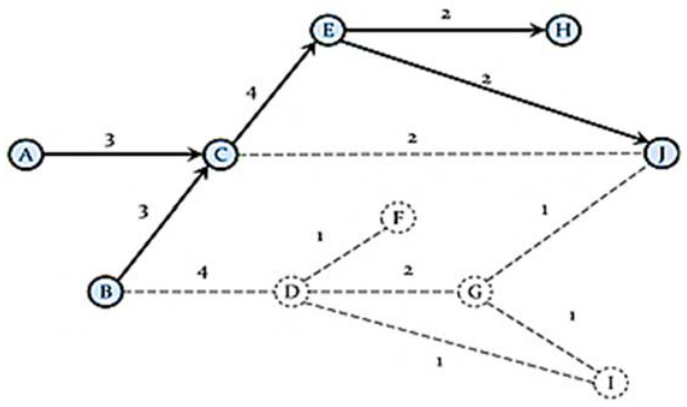
Figure 2. Schematic of the calculation of link weight by using the search path count (SPC).